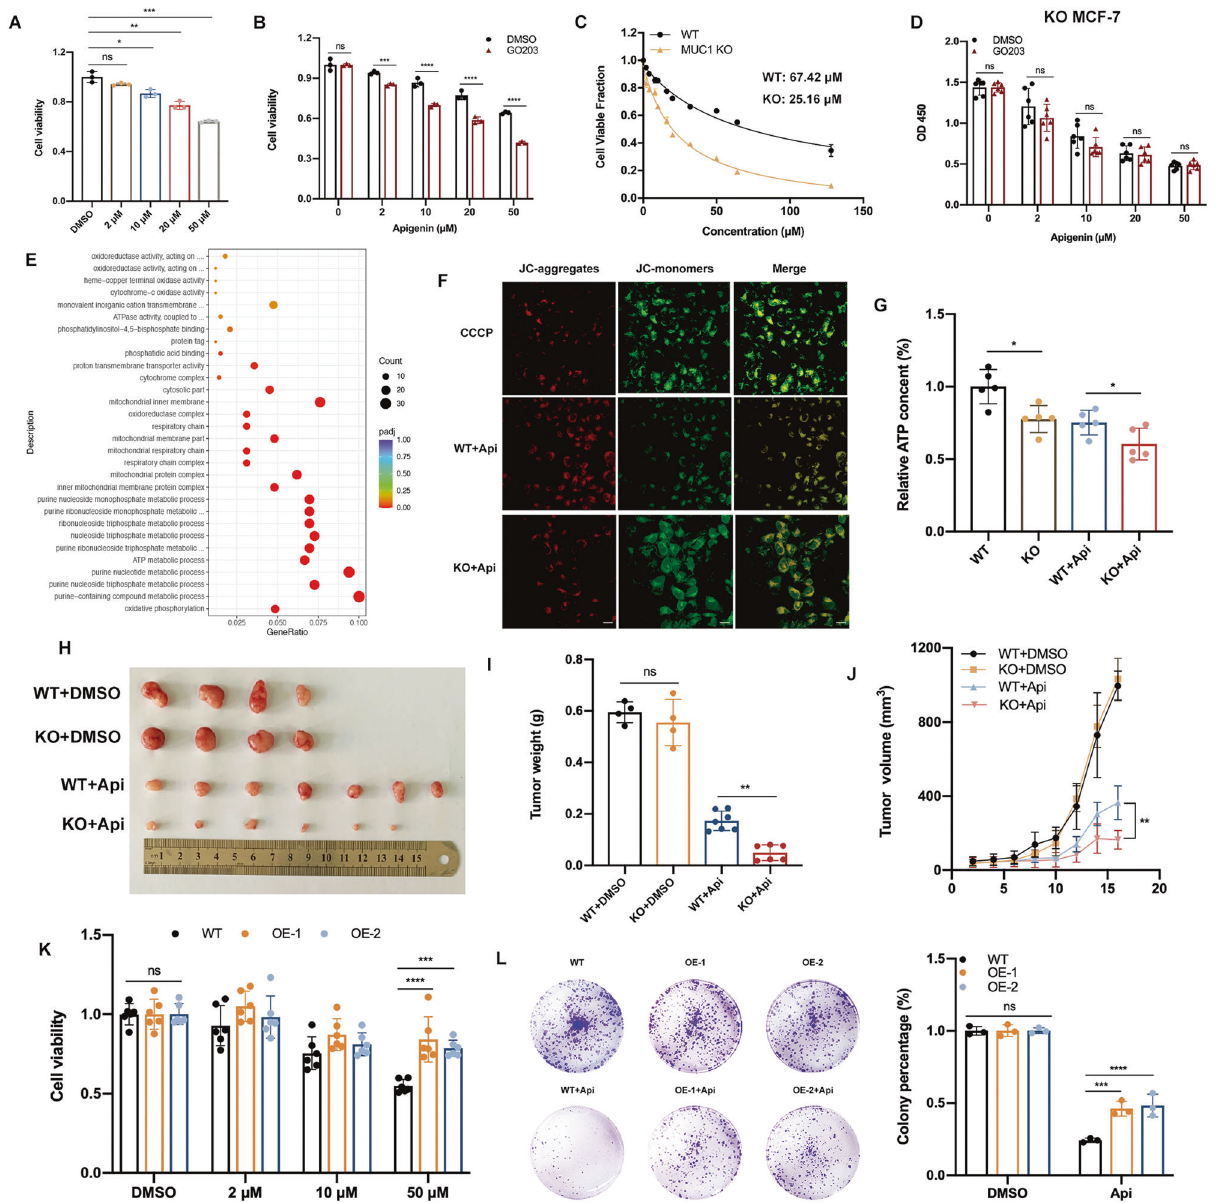
treated with various concentrations of apigenin for 48 h. D Cell viability of KO cells treated with 5 μ M GO203 combined with certain concentrations of apigenin, respectively. E The GO analysis of WT/KO cells (downregulated signaling pathways). F Determination of Mitochondrial membrane potential in WT/KO cells treated with apigenin. After apigenin exposure for 48 h, the red fl uorescence intensity of KO cells was downregulated, while green fl uorescence intensity was upregulated compared with the WT group. These changes indicated the decreased membrane potential. G Relative ATP content of WT/KO cells with/without apigenin treatment. H Xenograft images were shown. WT/KO MCF-7 cells seeded female BALB/c mice were treated with drug solvent or 40 mg/kg/d (i.p.) of apigenin for 16 days. I Tumor weight was shown. J Tumor size was shown. Mean ± SD. K Cell viability of MUC1 overexpressing MCF-7 cell lines treated with apigenin for 48 h. L Colony formation of MUC1 overexpressing MCF-7 cell lines treated with 25 μ M apigenin for a week. Each group was analyzed in triplicate. * P < 0.05; ** P < 0.01; *** P < 0.001 for